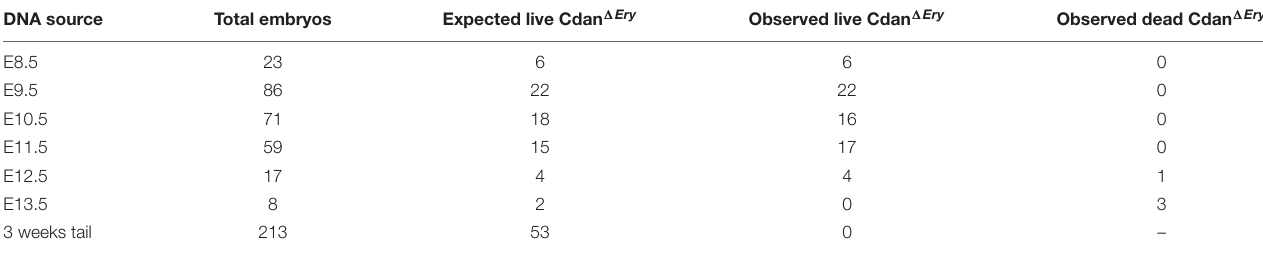
TABLE 1 | The number of Cdan (cid:49) Ery embryos generated from Cdan f / f X Cdan f / +; ErGFPcre crossing. DNA source